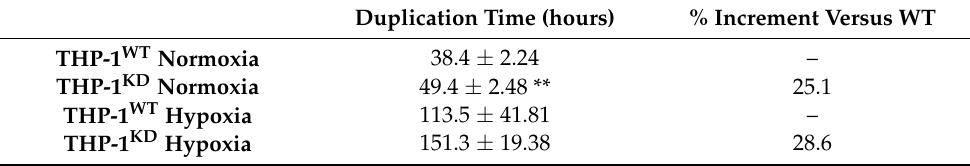
Figure 1. Effects of TKTL1 knockdown on TKTL1 and TKT gene expression and the pentose phos- phate pathway. ( A ) Effects of TKTL1 silencing on TKTL1 and TKT gene expression. RT-PCR per- formed using PPA1 as a housekeeping gene for data normalization. Decrease in TKTL1 expression determined as 63.3% ± 0.03. Data shown as mean ± SD (n = 3) of normalized values. Enzymatic activity assays performed through spectrophotometry in normoxia and hypoxia (1% O 2 ); for ( B ) transketolase (TKT), ( C ) glucose-6-phosphate dehydrogenase (G6PD) and ( D ) 6-phospo-gluconate dehydrogenase (6PGD). Data represented as mean ± SD (n = 2). Statistically significant differences in all panels were determined by two-tailed independent sample Student’s t -test: p < 0.05 (*). p < 0.01 (**). p < 0.001 (***). Table 1. Duplication times of THP-1 WT and THP-1 KD under normoxia and